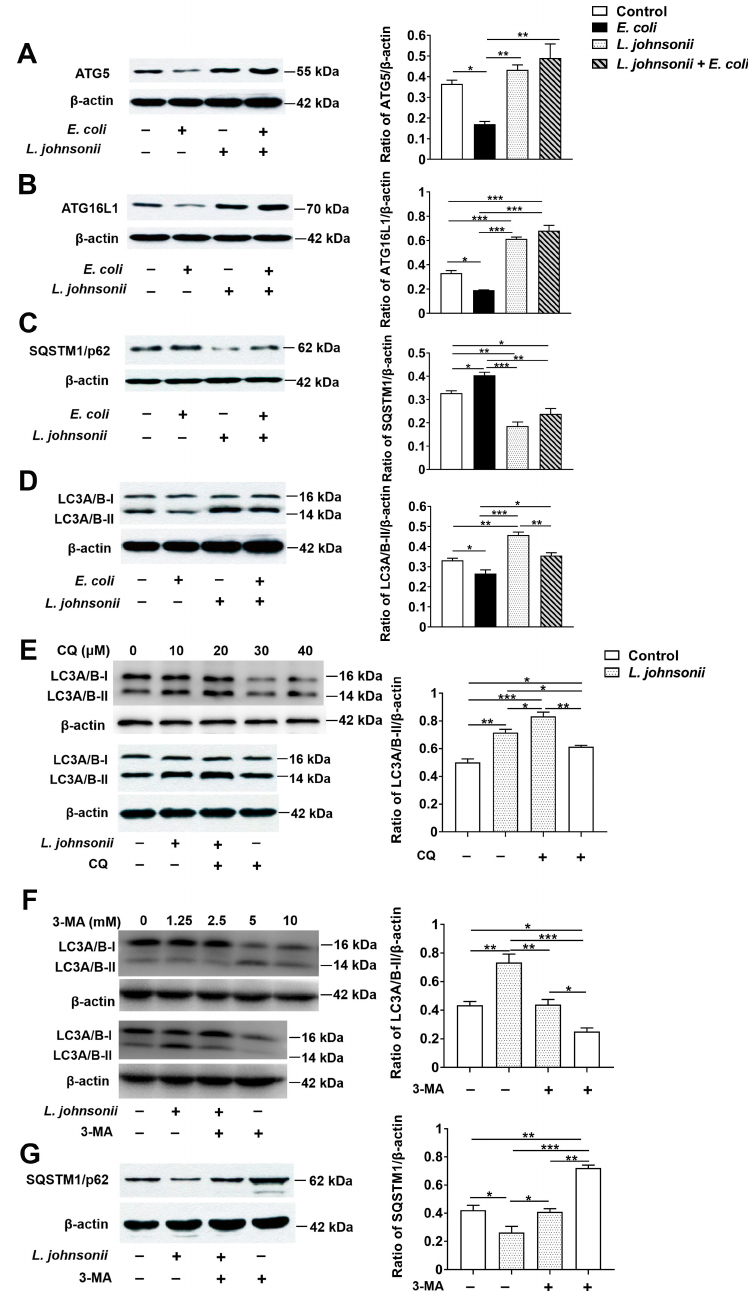
Figure 5. Pre-incubation with L. johnsonii L531 inhibited E. coli -induced autophagy in PMECs. Western blotting analysis of ( A ) ATG5, ( B ) ATG16L1, ( C ) SQSTM1, ( D ) LC3A / B in PMECs collected at 6 h post-infection (left panels). Representative panels showing expression of ATG5, ATG16L1, SQSTM1, and LC3A / B. Results are exhibited as the ratio of protein band intensity for ATG5, ATG16L1, SQSTM1, and LC3A / B-II to the intensity of the β -actin band (right panels), ( E ) PMECs treated with the di ff erent working conditions of CQ for 2 h to inhibit autophagic degradation. The addition of optimum working conditions of CQ led to the prominent accumulation of LC3A / B-II in both di ff erent groups. PMECs treated with the di ff erent working conditions of 3-MA for 12 h to inhibit the synthesis of autophagosomes. Western blotting analysis of ( F ) LC3A / B-II and ( G ) SQSTM1 in cells treated with optimum working conditions of 3MA. Data were presented as the mean ± SEM of three independent experiments. * p < 0.05; ** p < 0.01; *** p <